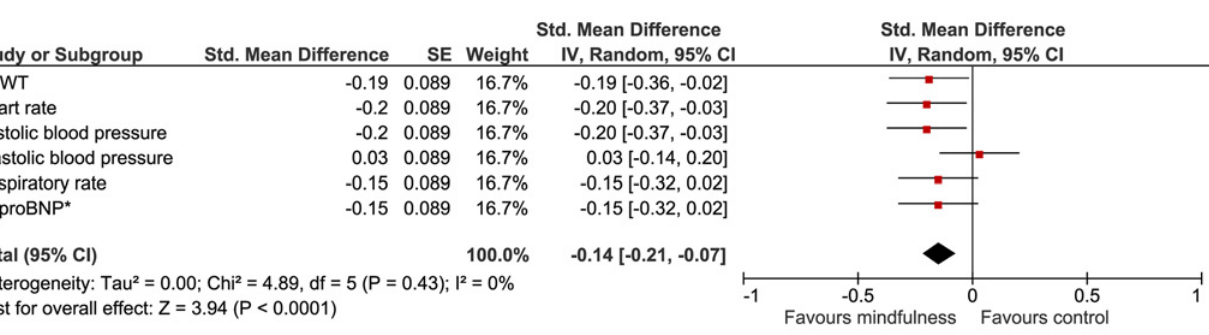
Fig 6. Forest plot showing the As-Treated Cohen ’ s D results of the effectiveness of the mindfulness intervention compared with usual care on the physiological outcomes. The width of the line indicates the 95%CI. All values lower than 0 indicate a significant difference in favour of the mindfulness